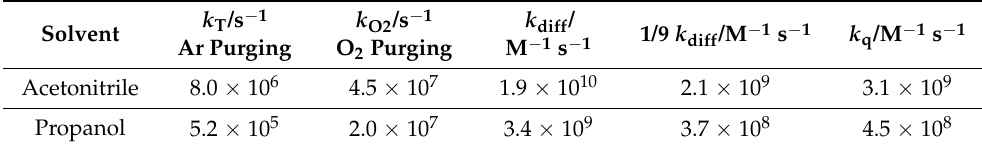
Table 3. 4Met-BAC triplet state characteristics in different